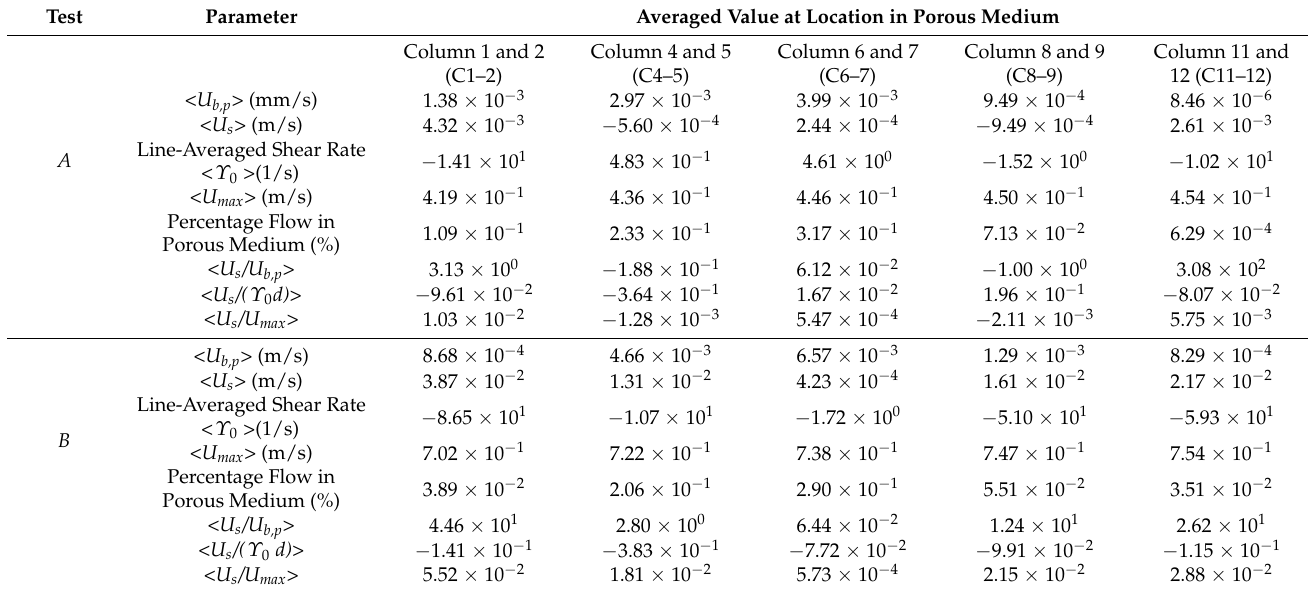
Table 2. Summary results of porous media parameters showing streamwise variation in midspan plane.